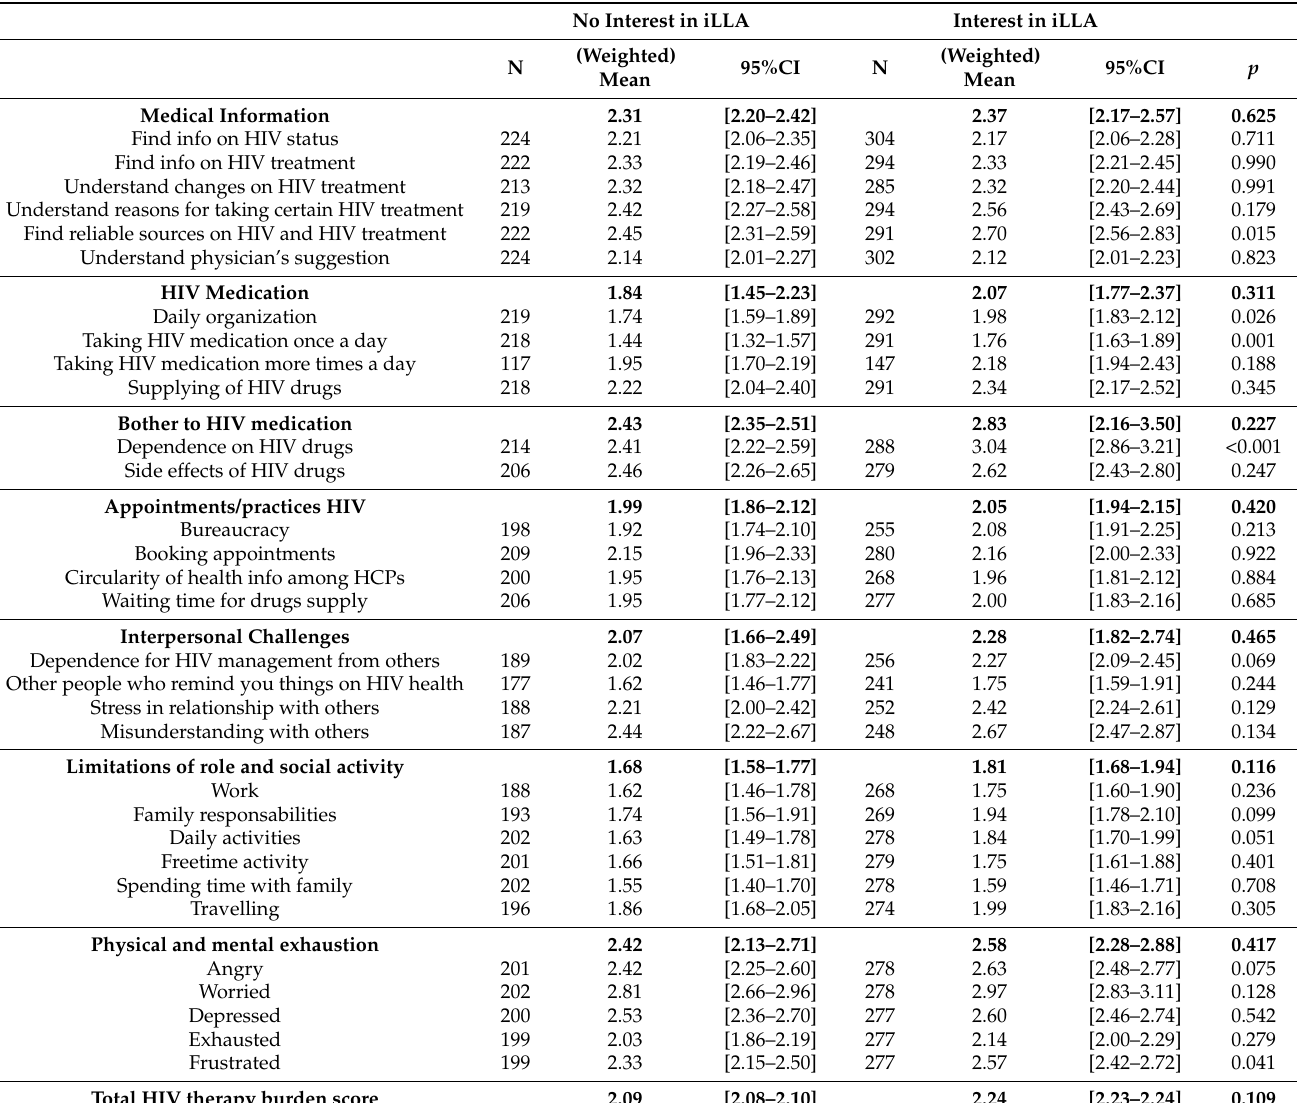
Table 4. Single items, domains and total results of “HIV treatment and diseases burden” questionnaire adapted from DT Eton et al., Qual Life Res 2017, according to interest in injecting long acting (mean and t-test for items, weighted mean and weighted linear regression for domains and